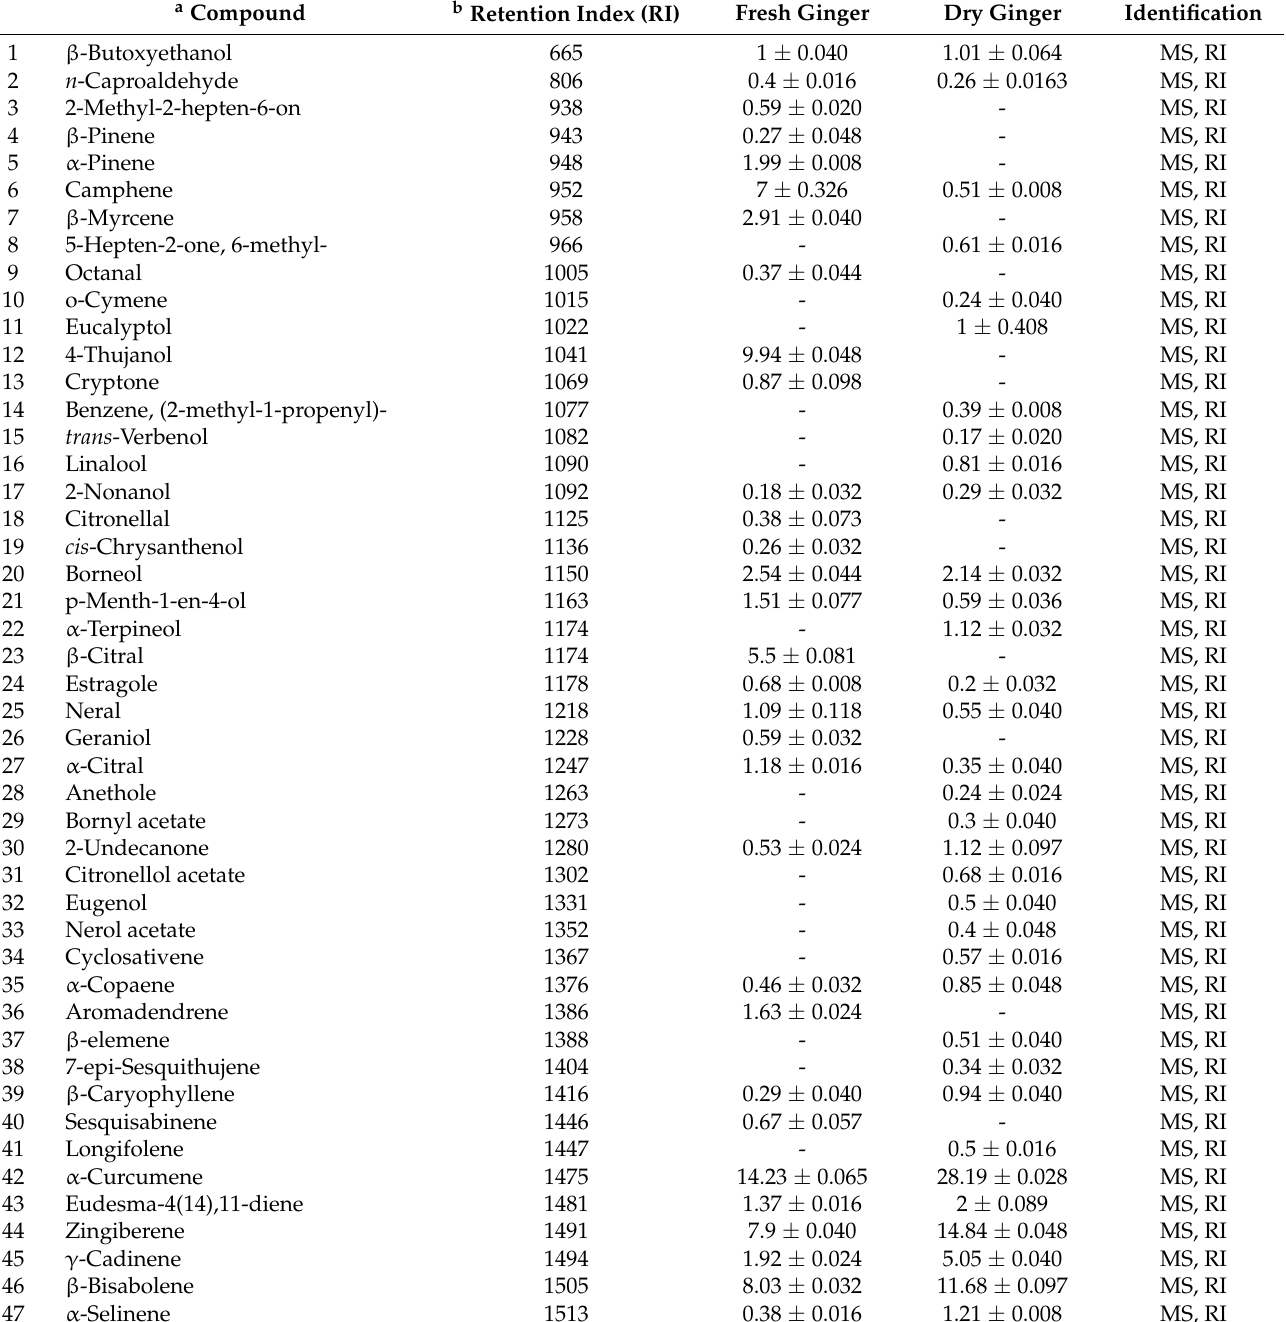
Table 1. Chemical composition and classifications of compounds of both fresh and dried ginger volatile